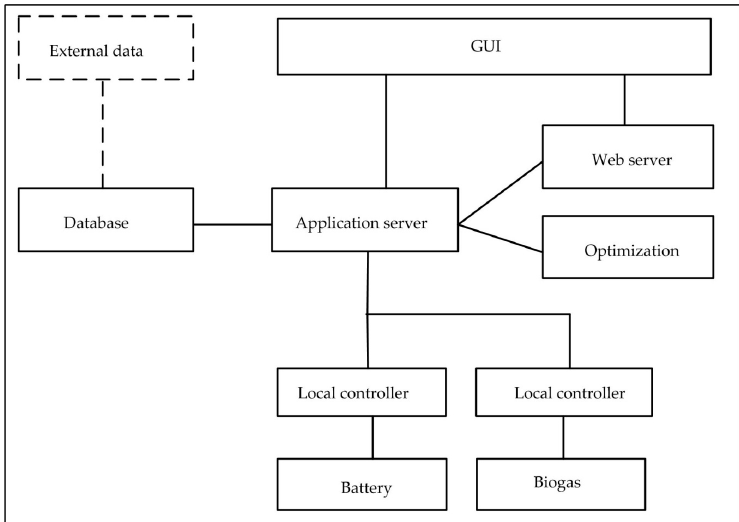
Figure 1. The virtual power plant (VPP) that was built during the study (adapted from the literature